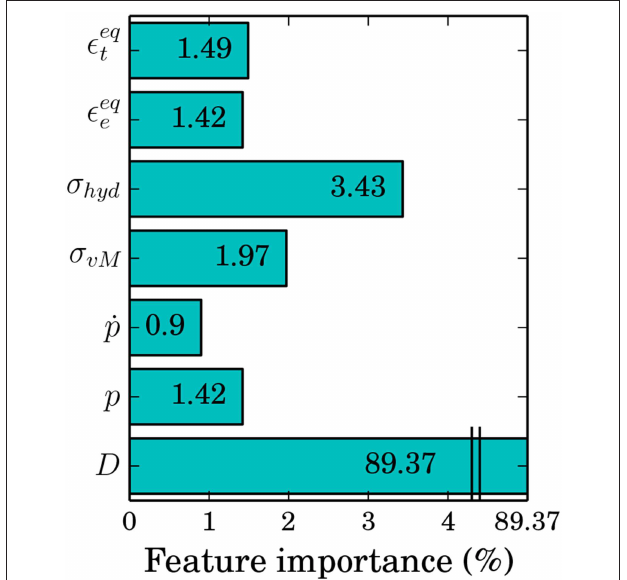
FIGURE 6 | Results of the feature importance presented in a bar plot showing the importance of each feature in percent. Here, the x-axis is only properly shown up to 4 % for clarification because all features, except for the damage parameter, show values < 4 % .